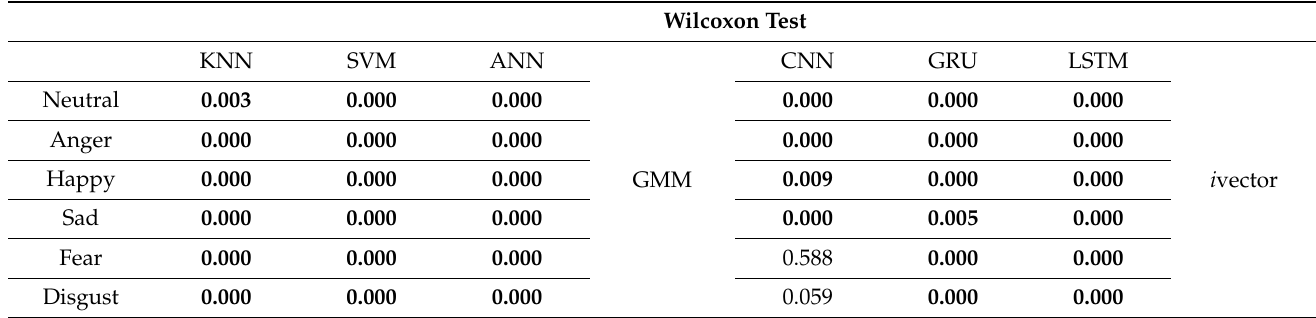
Figure 7. DET curves with each based on GMM, KNN, SVM, ANN, CNN, LSTM, and GRU models for the different emotional states using the Emirati database.